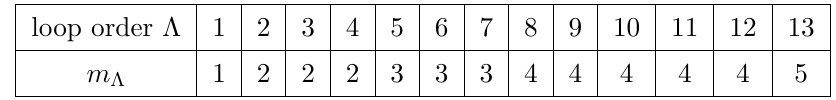
Table 1 . Maximal shifts m